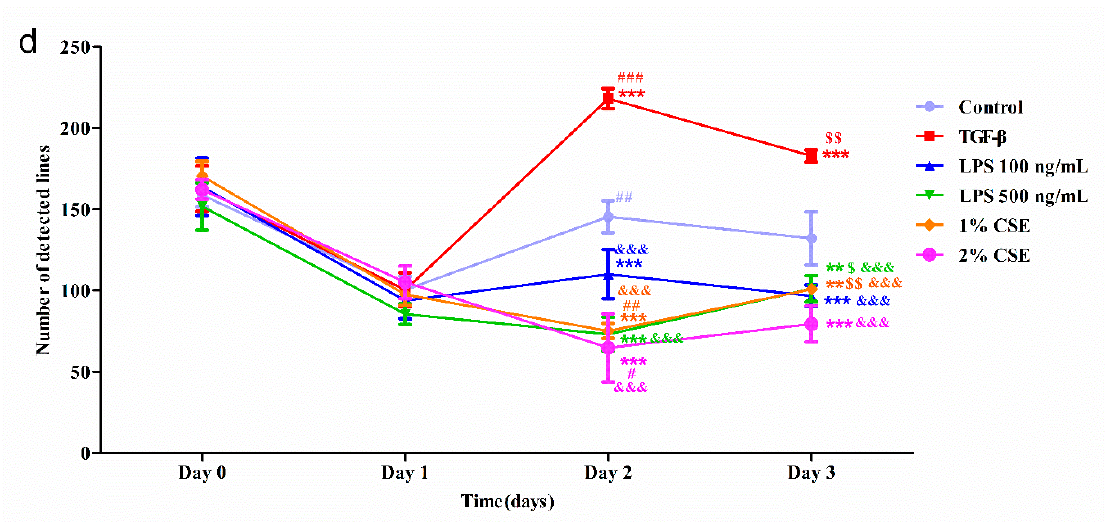
Figure 6. The quantification of the length and quantity of detected lines. ( a ) A scatter dot plot of the length of the detected lines between the control and TGF- β groups. Pie charts represent the percentages of different length levels on day 2: 20 ‒ 25, 25 ‒ 30, 30 ‒ 40, and >40 pixels. ( b ) A scatter dot plot comparing the six different groups (control; TGF- β ; LPS 100 ng/mL and 500 ng/mL; 1% and 2% CSE groups) on day 2. ( c ) A scatter dot comparing the six different treatments on day 3. ( d ) A line graph focused on the number of lines detected from day 0 to 3 in the six groups. n = 3. *** p < 0.001, ** p < 0.01 vs. control group in different time points. ### p < 0.001, ## p < 0.01, # p < 0.05 Day 1 vs. Day 2. $$ p < 0.01, $ p < 0.05 Day 2 vs. Day 3. &&& p < 0.001 vs. TGF- β group in different time points.